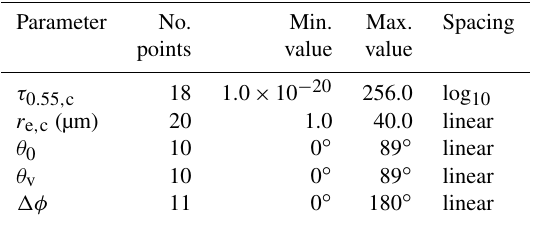
Table 1. The dimensions of the ORAC LUTs used in the liquid wa- ter cloud retrieval. Note that not all LUTs are functions of all vari- ables (for instance, atmospheric transmission terms are functions of a single zenith angle